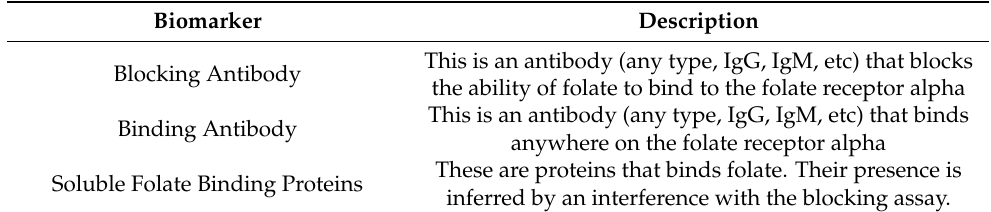
Table 1. Folate Receptor Alpha Biomarkers Related to Autism Spectrum Disorder. Biomarker Description This is an antibody (any type, IgG, IgM, etc) that blocks Blocking Antibody the ability of folate to bind to the folate receptor alpha This is an antibody (any type, IgG, IgM, etc) that binds Binding Antibody anywhere on the folate receptor alpha These are proteins that binds folate. Their presence is Soluble Folate Binding Proteins inferred by an interference with the blocking